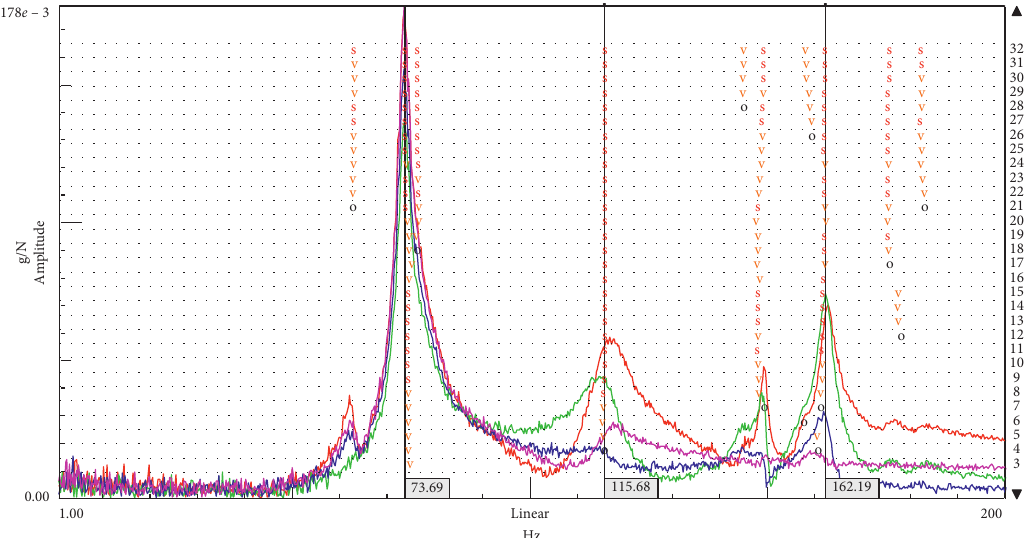
Figure 8: Modal stabilization diagram of the test rig.